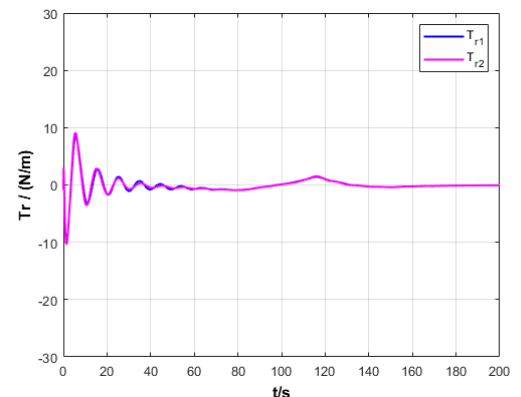
Figure 15. Turning torque variation of USV under two strategies.